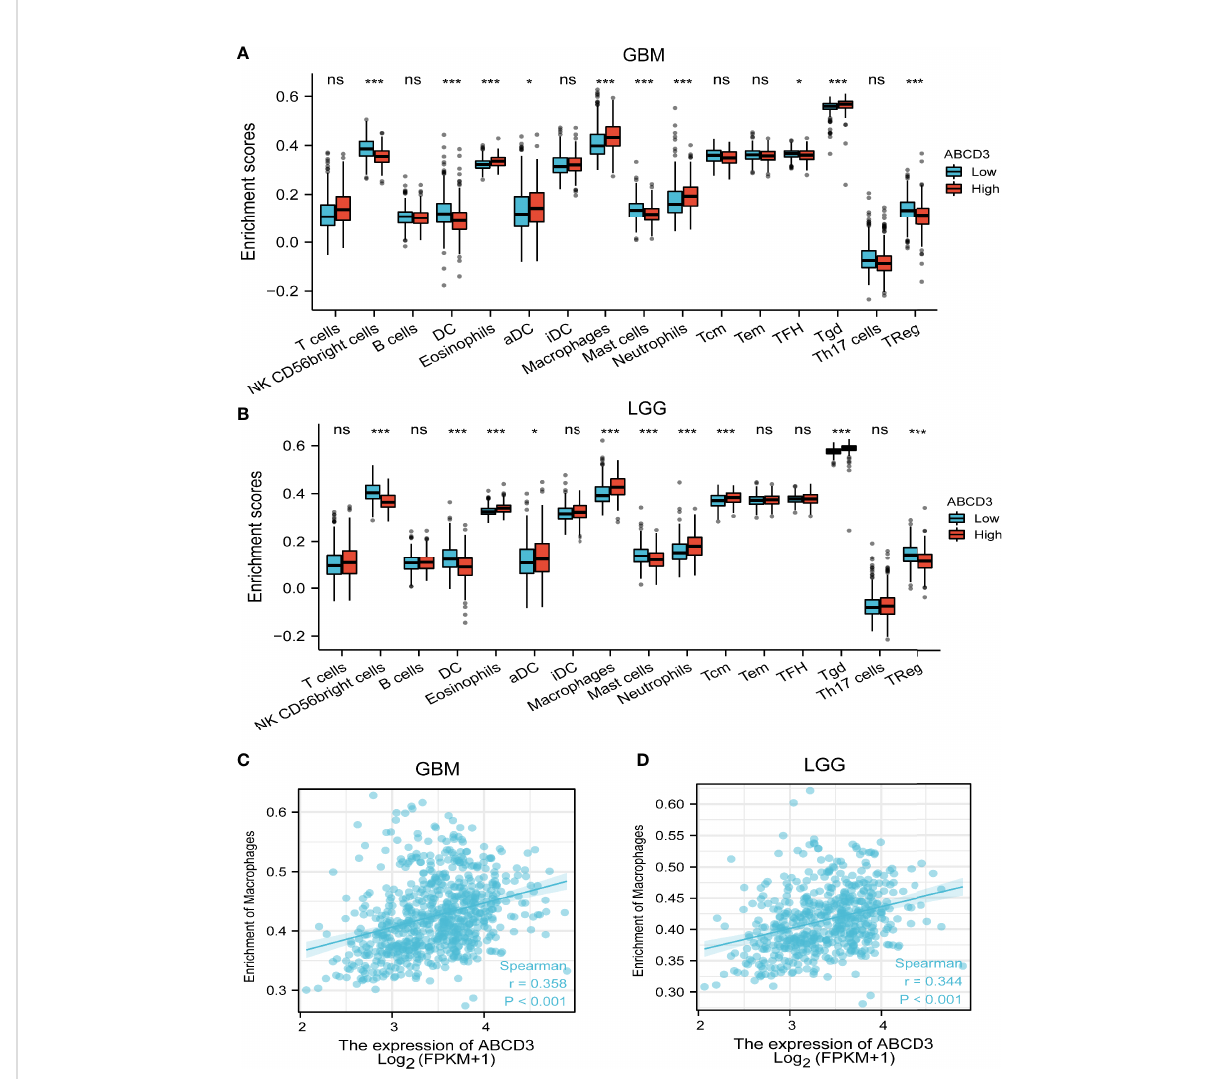
FIGURE 4 Relationship between ABCD3 expression and tumor-in fi ltrating immune cells. The proportion of 24 subpopulations of immune cell in fi ltration between the high and low expression of ABCD3 in GBM (A) or LGG (B) samples. Macrophages were mostly increased in the high ABCD3 expression group compared with the low ABCD3 expression group, while pDC cells were apparently decreased in the high expression group in both GBM and LGG. The macrophage in fi ltrate correlated with both GBM (C) and LGG (D) . ns, no signi fi cance; *, P < 0.05; ***, P <